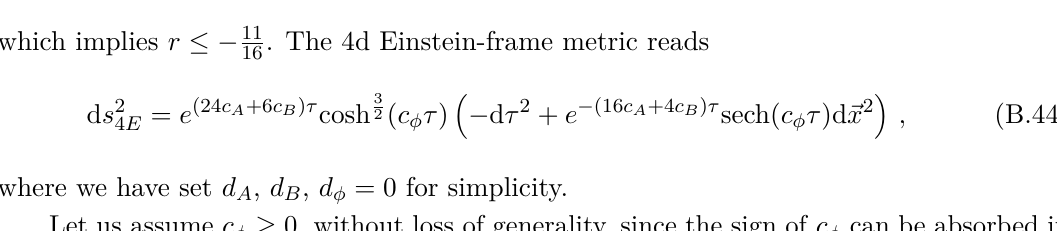
Figure 13 . Plot of